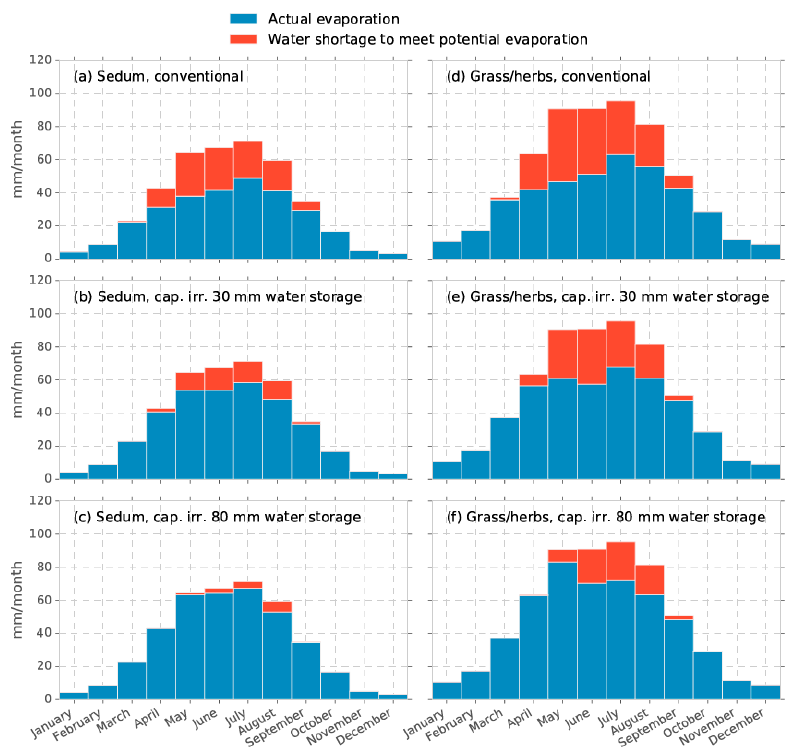
Figure 9. Long-term monthly mean evaporation and water shortage (difference between E p and E a ) of six different green roof setups.